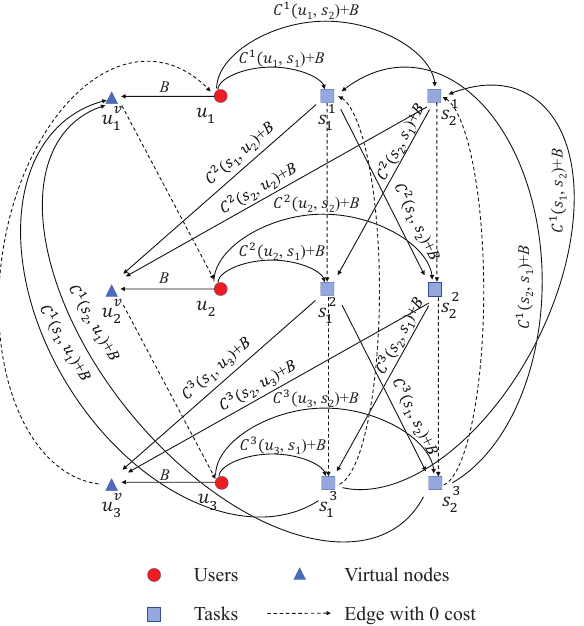
Figure 4. An example of the transformed graph of the single-TSP for 3 users and 2 task